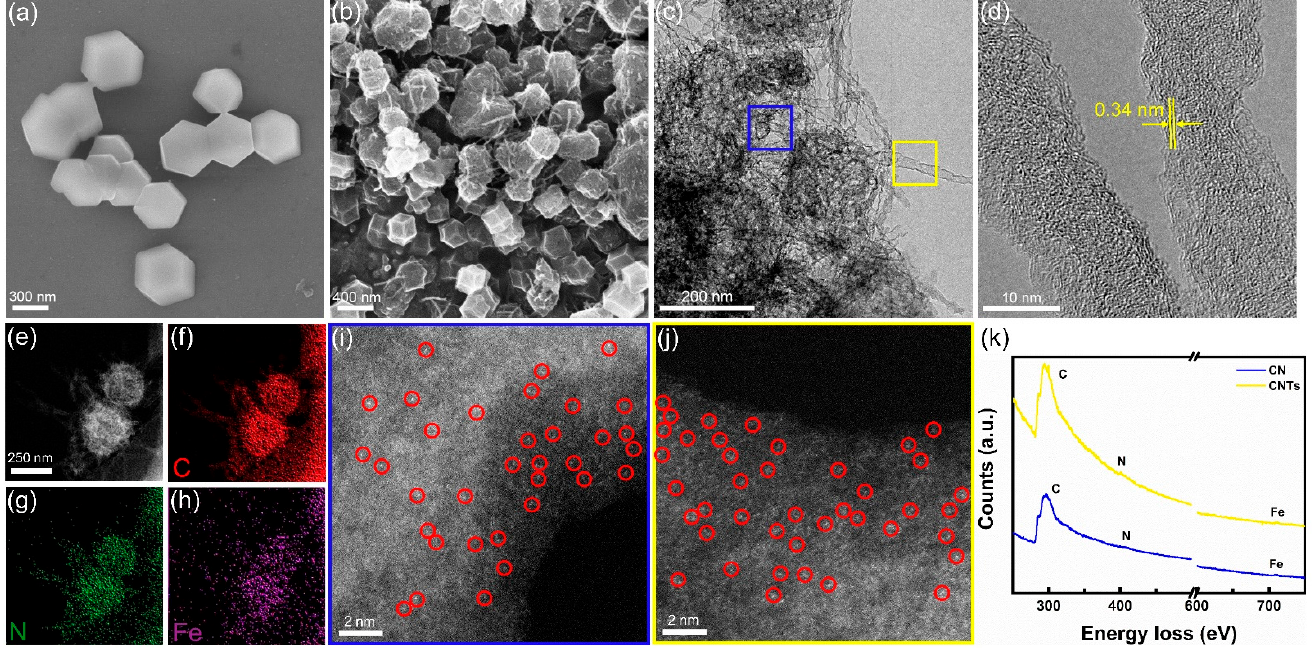
Figure 2. SEM images of ( a ) Fe(acac) 3 -0.1@ZIF-8 and ( b ) FeSA-NC/CNTs. ( c ) TEM and ( d ) HRTEM images of FeSA-NC/CNTs. ( e – h ) STEM-EDS elemental maps of C, Fe, and N of the FeSA-NC/CNTs sample shown in ( e ). AC-HAADF-STEM images of ( i ) N-doped carbon matrix and ( j ) carbon nanotubes, corresponding to the blue and yellow areas in ( c ), respectively. ( k ) Electron energy-loss spectroscopy showing the C K-edge, N K-edge, and Fe L-edge acquired from the marked region in ( c ). Furthermore, AC-HAADF-STEM was used to visualize the microstructure of NC and To further explore the formation mechanism of FeSA-NC/CNTs, MOF precursors with different contents of Fe(acac) 3 were synthesized. It was found that after pyrolysis at